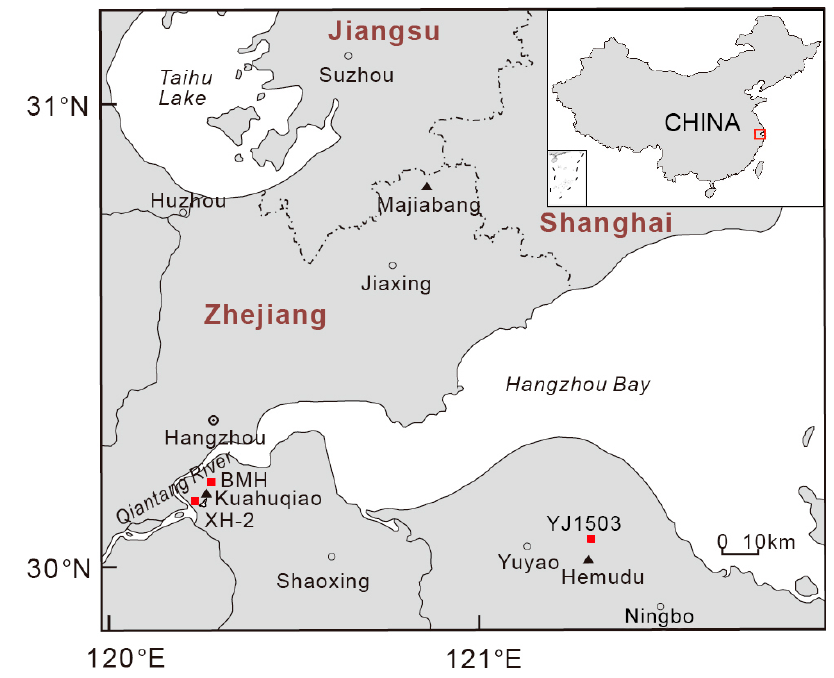
Figure 1. Location map with the core XH-2 site in the Xianghu area, Zhejiang province, eastern China. Table 1. Sample information for testing.